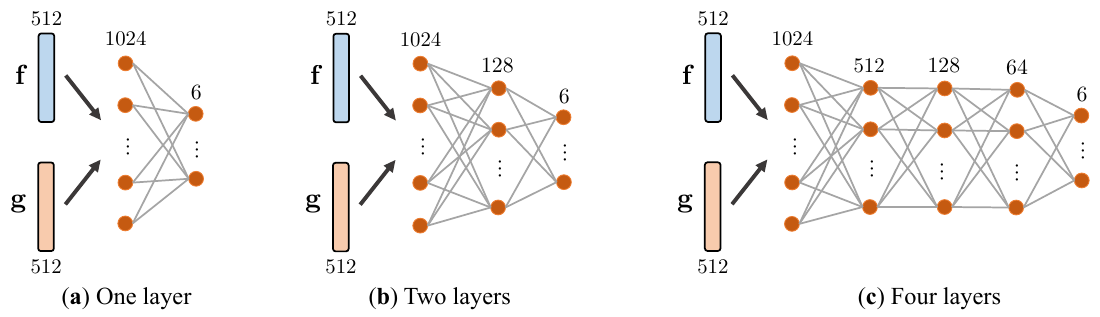
Figure 4. Three settings of fusion network: one layer, two layers, and four layers. For example, two layers indicate that fusion network has two fully connected layers, with 1024 and 128 ReLU units, respectively. The output of fully connected layers is fed to the softmax layer, which has six units, representing the number of